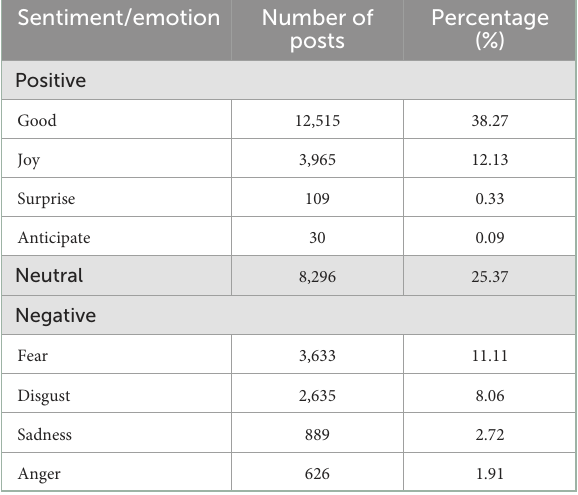
TABLE 3 Sentiment and emotion distribution of China